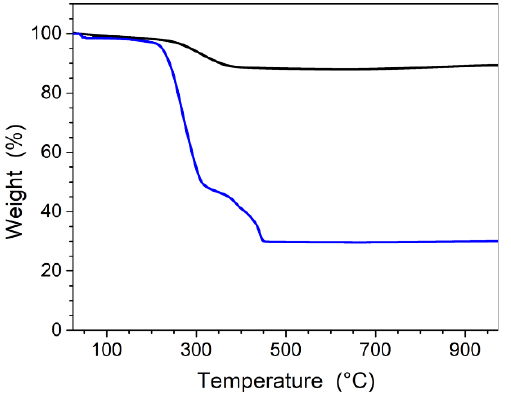
Figure A2. TGA curves of before (blue) and after (black) washing and size selection.